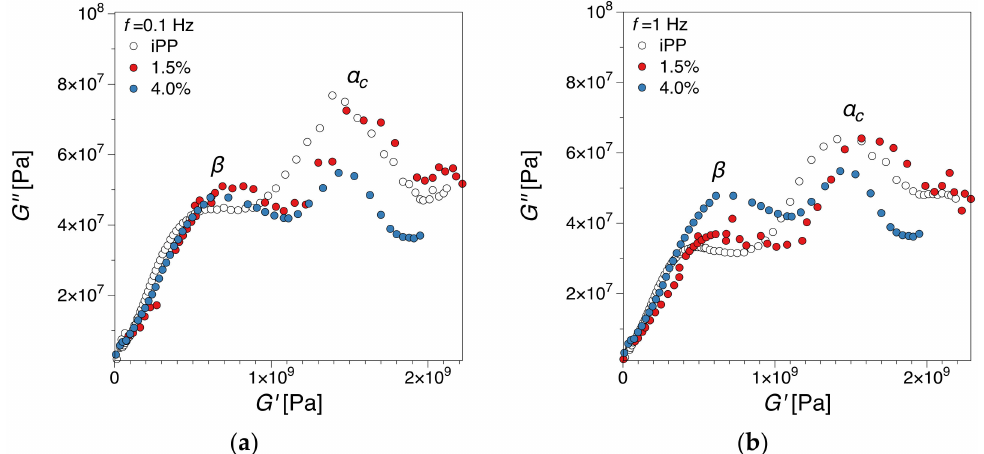
Figure 6. Cole-Cole plots for iPP, and iPP with 1.5 and 4 wt.% of HrGO at ( a ) 0.1 Hz, ( b ) 1 Hz, Temperature decreases from left to right on the